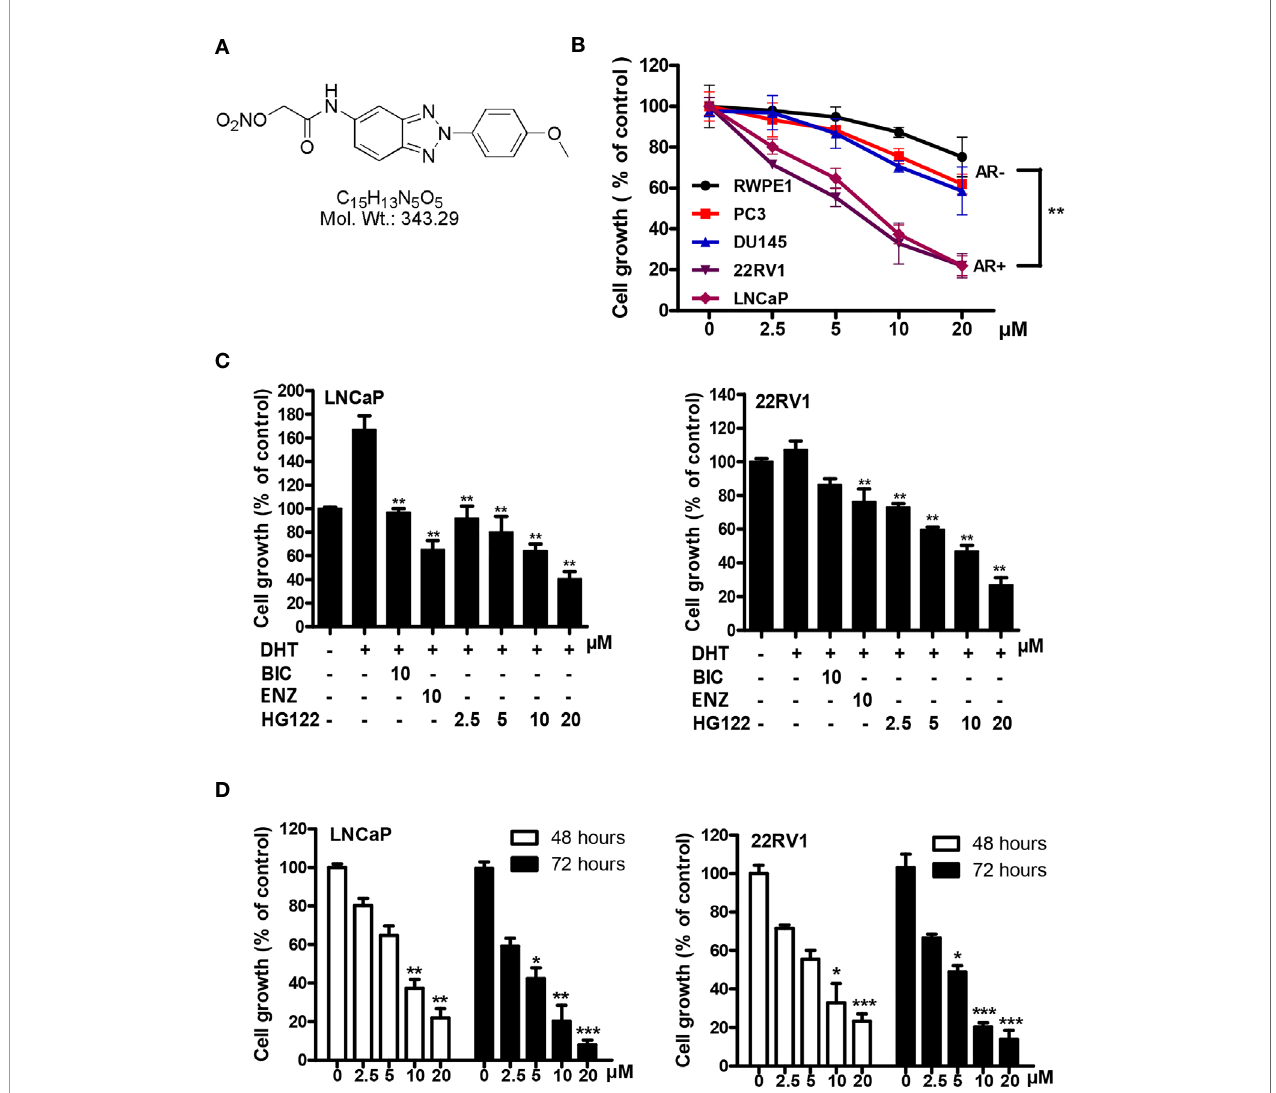
FIGURE 1 | Inhibitory effects of HG122 on the proliferation of PCa cell lines. (A) The chemical structure of HG122. (B) The effect of HG122 on cell growth. LNCaP, 22Rv1, PC3, DU145, and normal prostate cells (RWPE1) were treated with HG122 for 48 h, and the viability of cells was determined using the MTS assay. (C) Histogram represents the effect of HG122 on DHT-induced cell growth in AR-positive cells (LNCaP and 22RV1). (D) The effect of HG122 on cell growth in AR-positive cells (LNCaP and 22RV1) after 48 h or 72 h. The values are represented as percent viable cells, where DMSO-treated cells are regarded as 100% viable. Each bar in the histogram represents means ± SD of three independent experiments, *, P < 0.05; **, P < 0.01; ***, P < 0.001, compared to the vehicle control